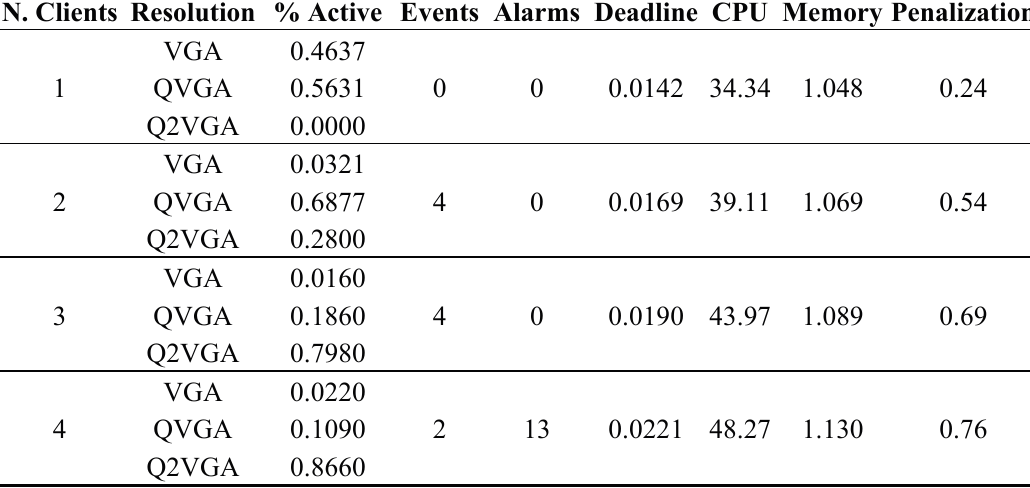
Table 4. Quantitative study of the system